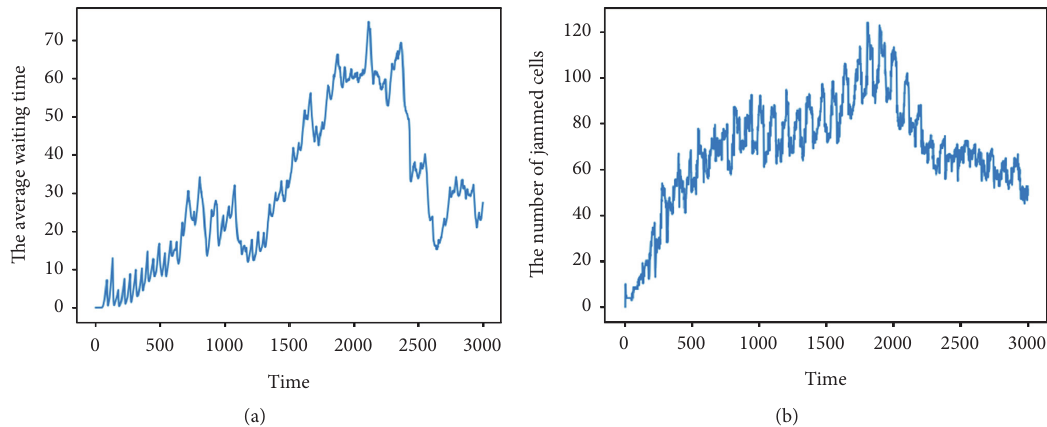
Figure 14: The number of jammed cells and vehicles’ waiting time of a 5 × 5 network with ETL strategy and two active ETL in a connected route. (a) Waiting time. (b) Number of jammed